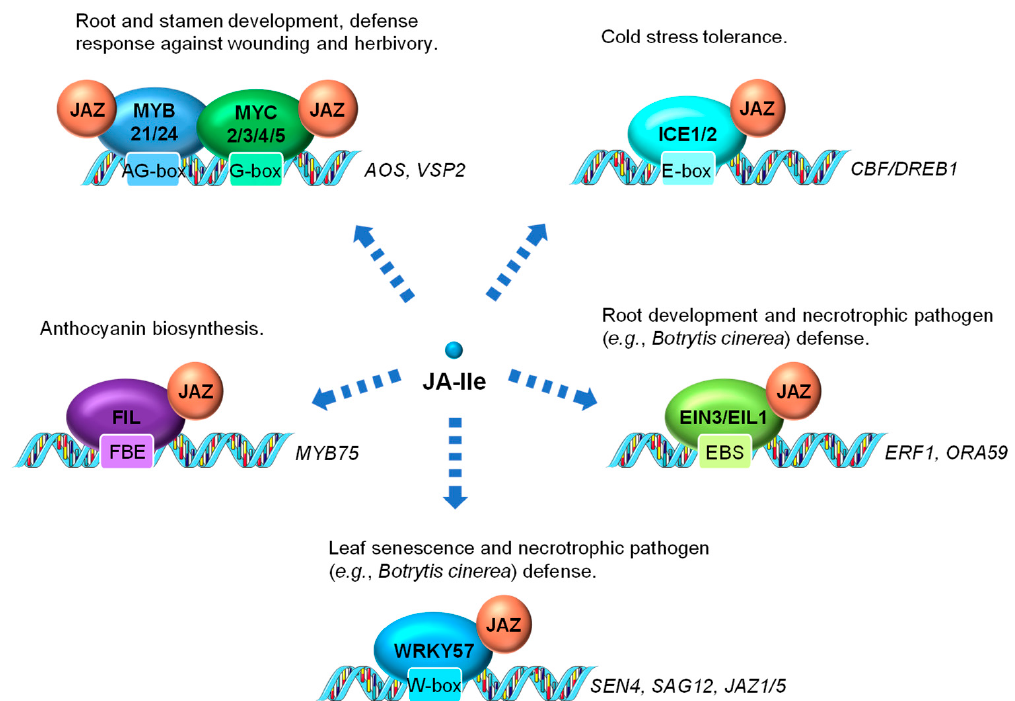
Figure 3. Examples of JA-regulated processes control through the interaction between JAZ and transcription factors (TFs). The MYC TFs, several R2R3-MYB family members (including MYB21 and MYB24), and other TFs (e.g., ICE1, EIN3, EIL1, and FIL) are direct targets of JAZ repressors. These TFs are activated by JA-mediated JAZ degradation and positively regulate JA responses. WRKY57 is also a direct target of JAZ but acts as a negative regulator of JA regulated leaf senescence and defense against necrotrophs. ICE1, INDUCER OF CBF EXPRESSION1; EIN3, ETHYLENE INSENSITIVE3; EIL1, EIN3-LIKE1; FIL, FILAMENTOUS FLOWER; EBS, EIN3 binding site; FBE, FIL DNA binding element.